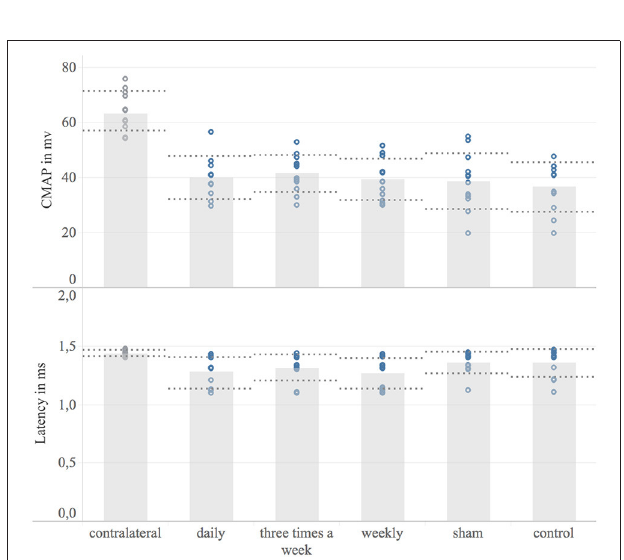
FIGURE 5 | Electrodiagnostic evaluation. Shown are bar graphs of the mean maximum compound muscle action potential (CMAP) in millivolt [mV] (Upper) and the distal latency in milliseconds [ms] (Lower) with standard deviation (dashed lines) combined with scatter plots of the measured data (dots). Underlying electrodiagnostic analyzes were conducted eight weeks post-surgery.